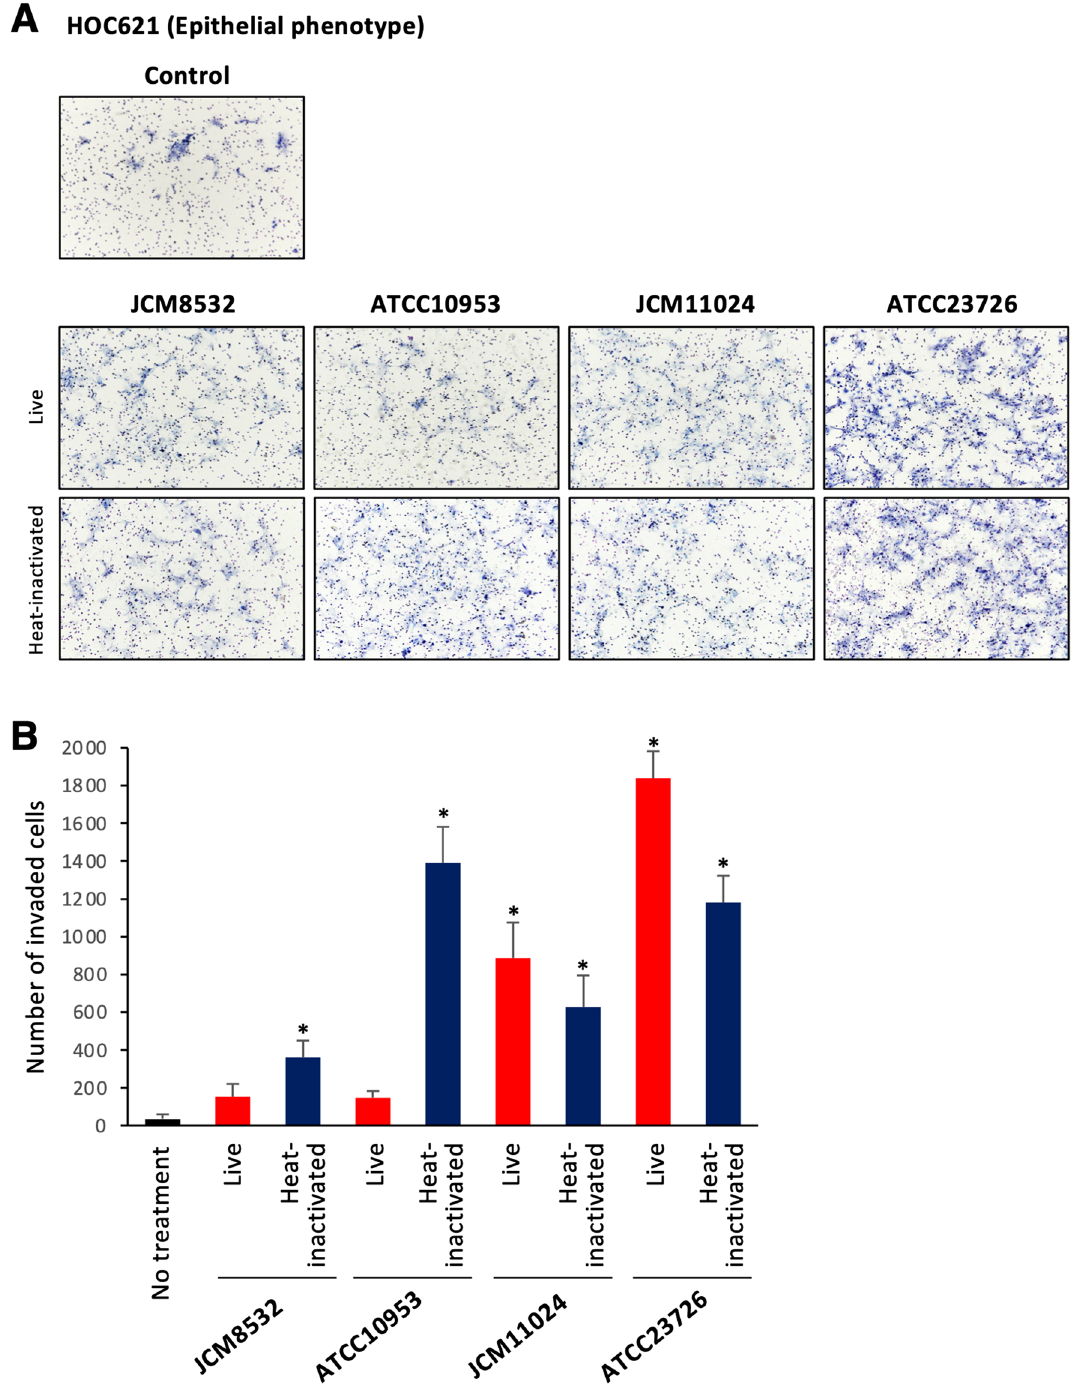
Figure 7. Invasive ability is promoted by co-culture with live or heat-inactivated F. nucleatum in epithelial phenotype, HOC621 cells. After co-culture with 4 subspecies of live or heat-inactivated F. nucleatum (MOI = 10), invasion ability was determined by in vitro invasion assay in epithelial phenotype, HOC621 cells. ( A ) Pictures showed the invaded OSCC cells after co-cultured with 4 subspecies of live or heat-inactivated F. nucleatum. ( B ) Graph shows the number of invaded OSCC cells after co-cultured with 4 subspecies of live or heat-inactivated F. nucleatum . Three independent experiments were used to calculate the mean ± S.D. (*) represents P -value of < 0.05 compared to control (no